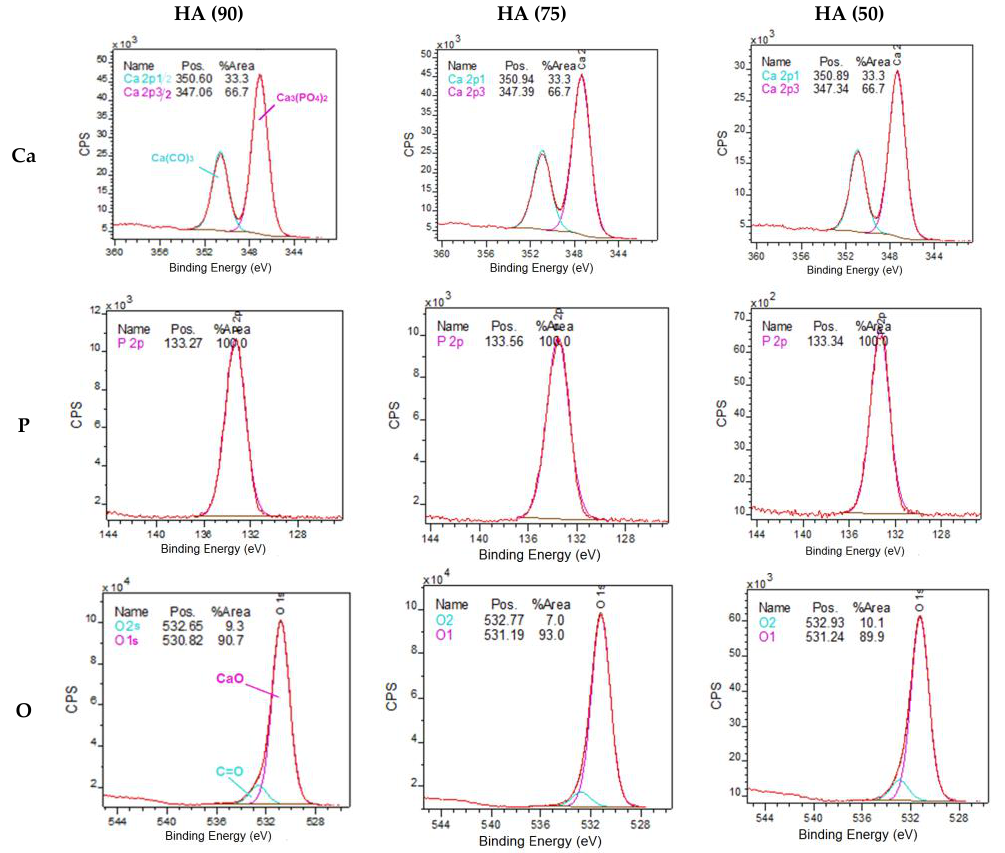
Figure 4. XPS spectra of Ca2p, P2p, and O1s of a porous ceramic surface ready for impregnation. The difference in the elemental composition of the surface between HA (90)–HA (50) does not go beyond 1% (Table 3). The HA sample (75) has the closest to the literary Ca/P Table 3. Elemental composition of the surface of porous HA frameworks after dissolution of NaCl, obtained by XPS, depth 5–10 nm. Element Content on the Surface, at. % Sample